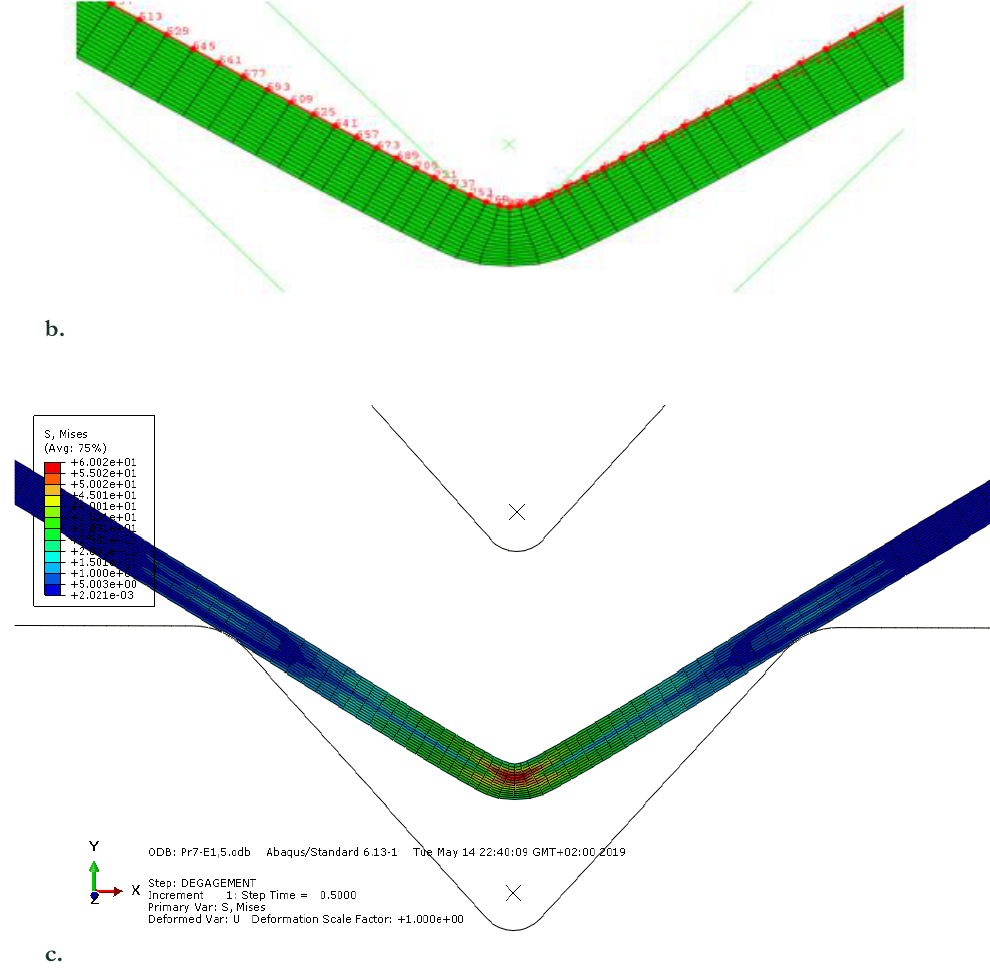
Fig. 4. Simulation results; a. the initial state before deformation, b. simulation of bending during the descent of the punch, c. simulation of springback after retraction of the punch.